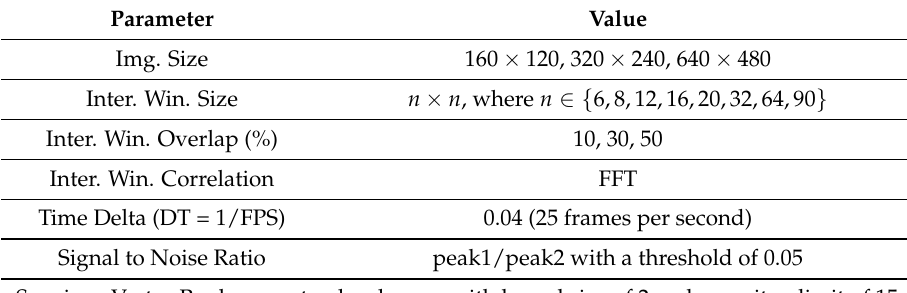
Table 1. DPIV parameters used in the proposed bee motion estimation